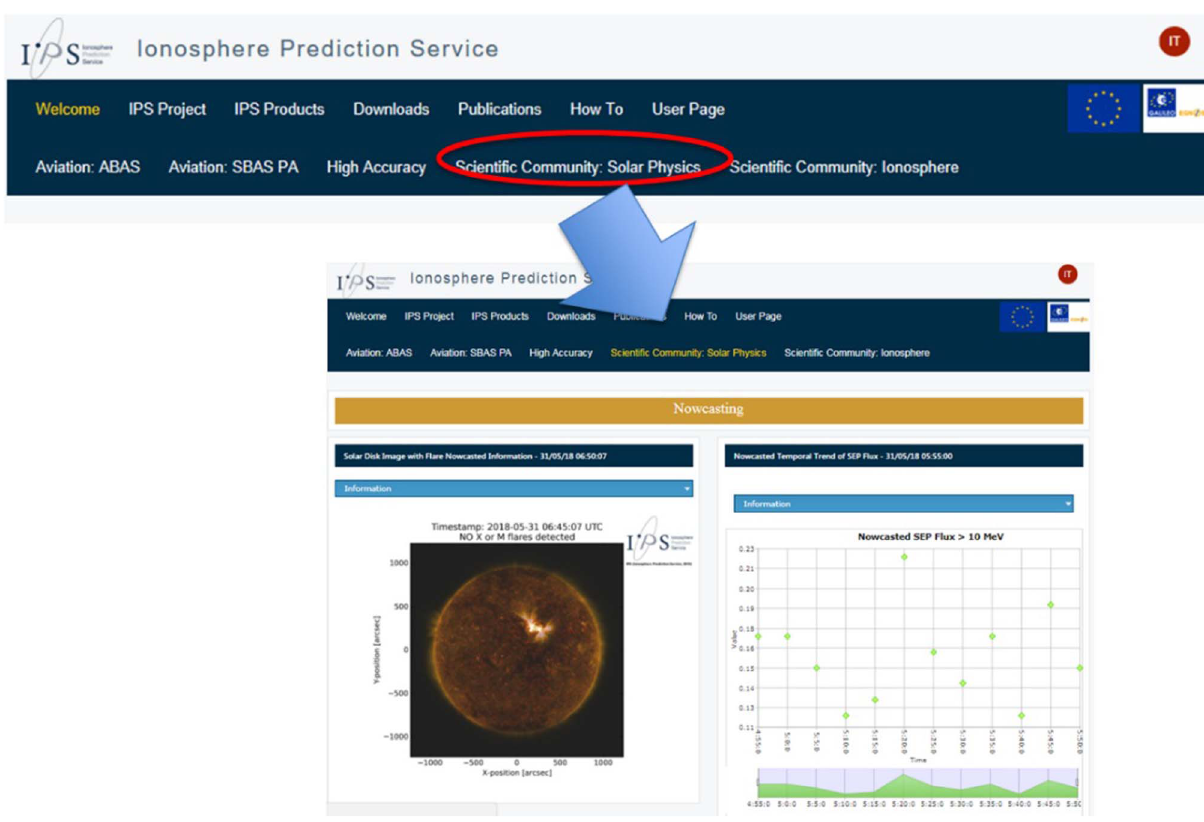
Fig. 5. An example of user community